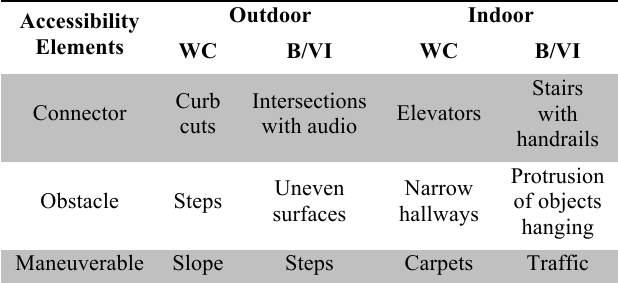
Table 1. Accessibility elements for wayfinding of